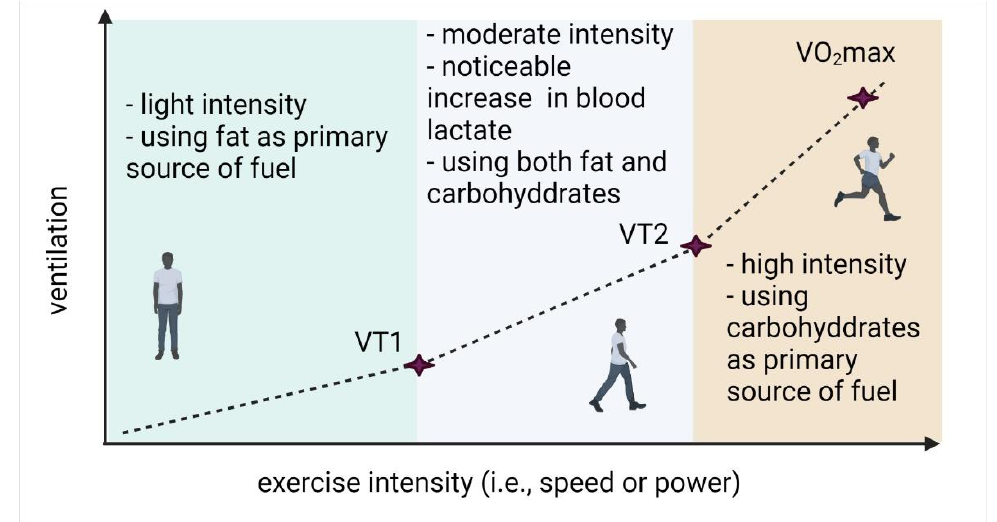
Figure 1. Schematic representation of the relationship between ventilation and exercise intensity as a function of ventilatory thresholds.